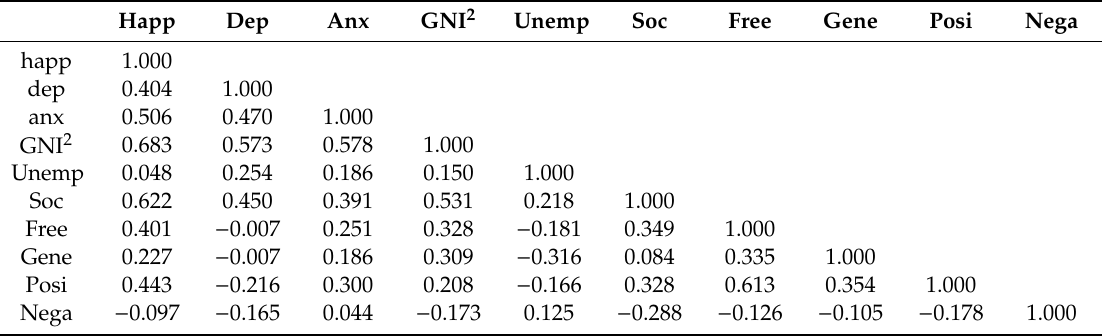
Table A1. The correlation matrix among variables in the full sample.